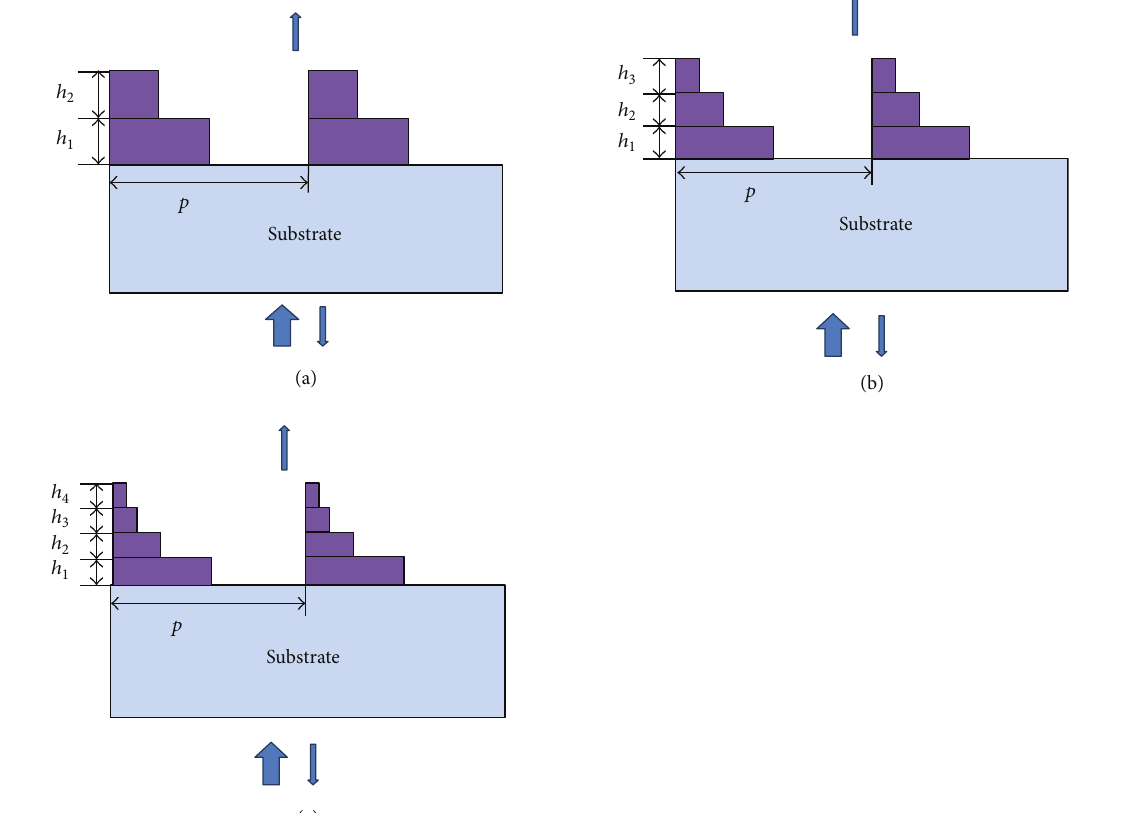
Figure 3: Schematic of subwavelength metal grating with relief structure composed of multiple.